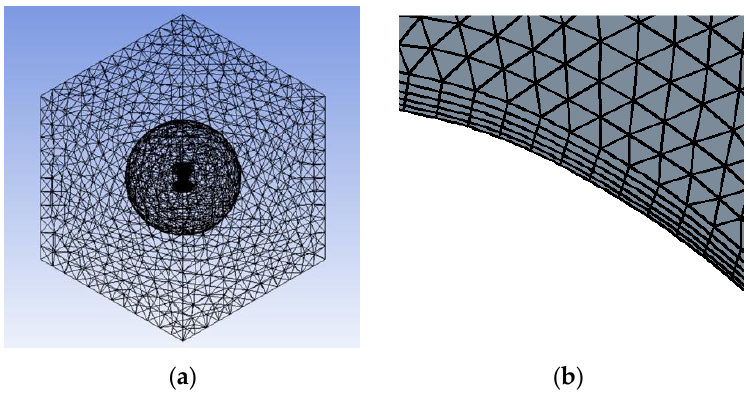
Figure 4. ( a ) Computational mesh; ( b ) boundary layer detail.